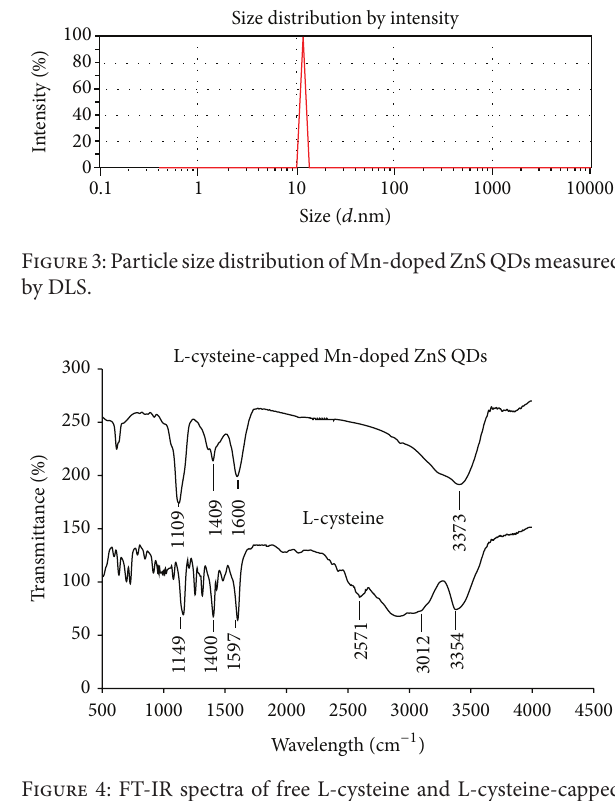
Figure 4: FT-IR spectra of free L-cysteine and L-cysteine-capped Mn-doped ZnS QDs.